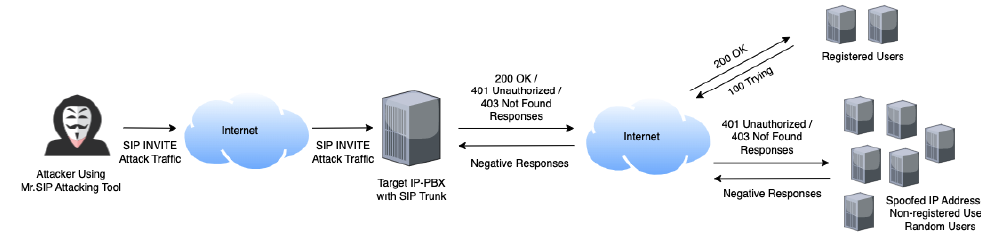
Figure 1. SIP-DRDoS attack network diagram.